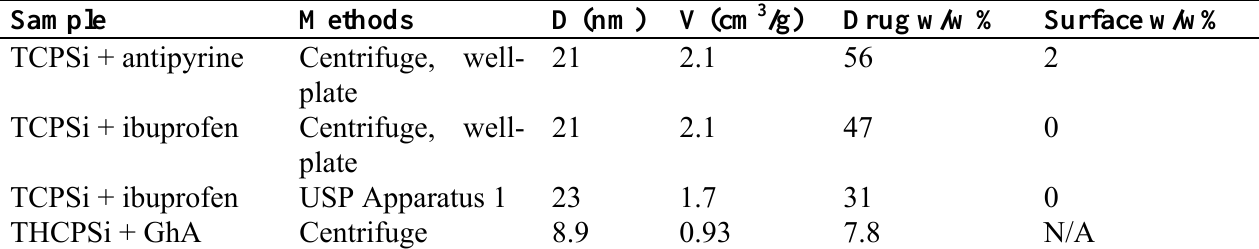
Table 1. In vitro dissolution methods used for different batches of PSi microparticles and characterization results of average pore diameter before drug load (D), pore volume before drug load (V), drug loading degree (w/w %) and amount of adsorbed drug on the external surface of the microparticles.